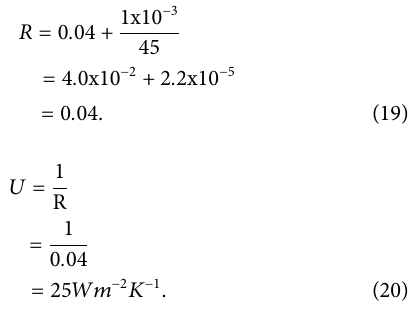
Figure 2 portrays the surface plot of the metabolic heat load distribution against the body surface area and the number of passengers. It can clearly be seen that the greater the number of passengers, the higher the metabolic heat dissipation into the cabin. Moreover, the plot shows that a larger body surface area coincides with a higher metabolic heat load. The factors highlighted in Figure 1 and Figure 2 should be taken into account when designing automotive AC systems.